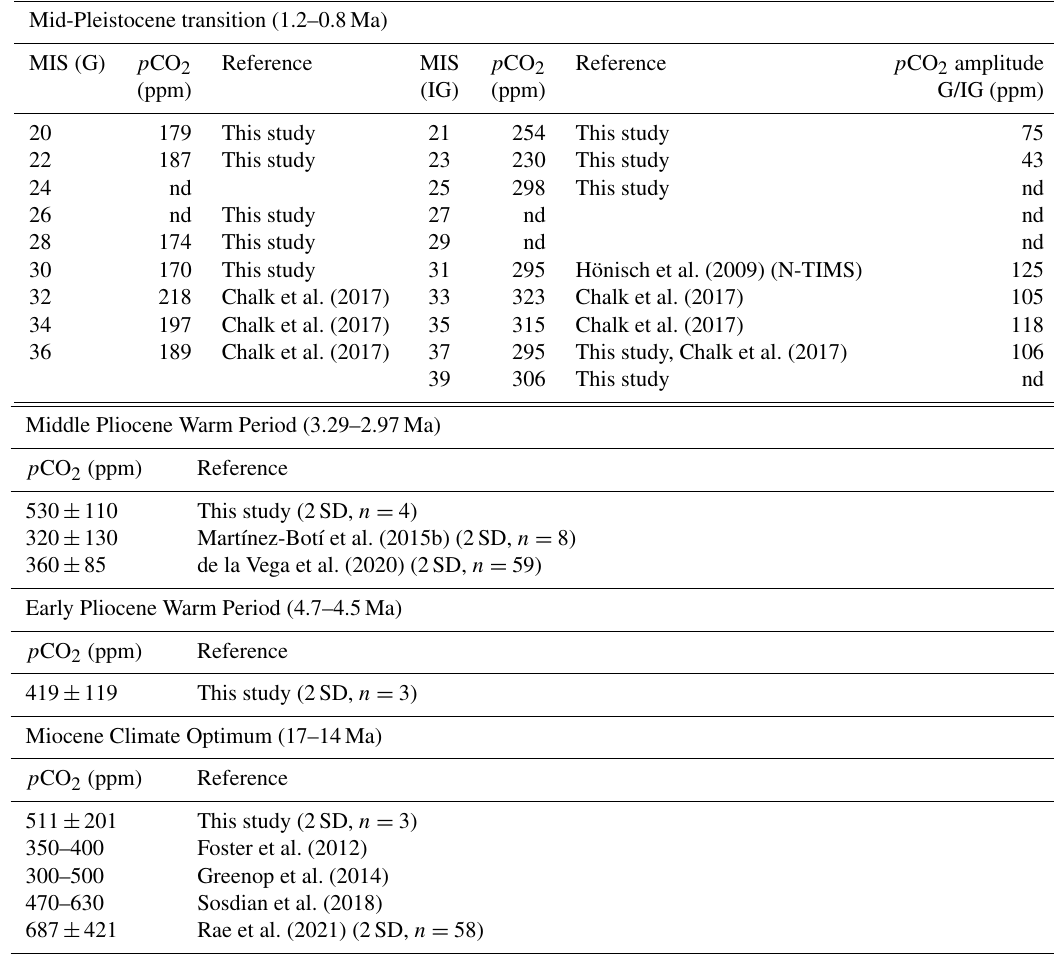
Table 2. Comparison of reconstructed p CO 2 values for key intervals in the last 16Myr. The abbreviation “nd” stands for